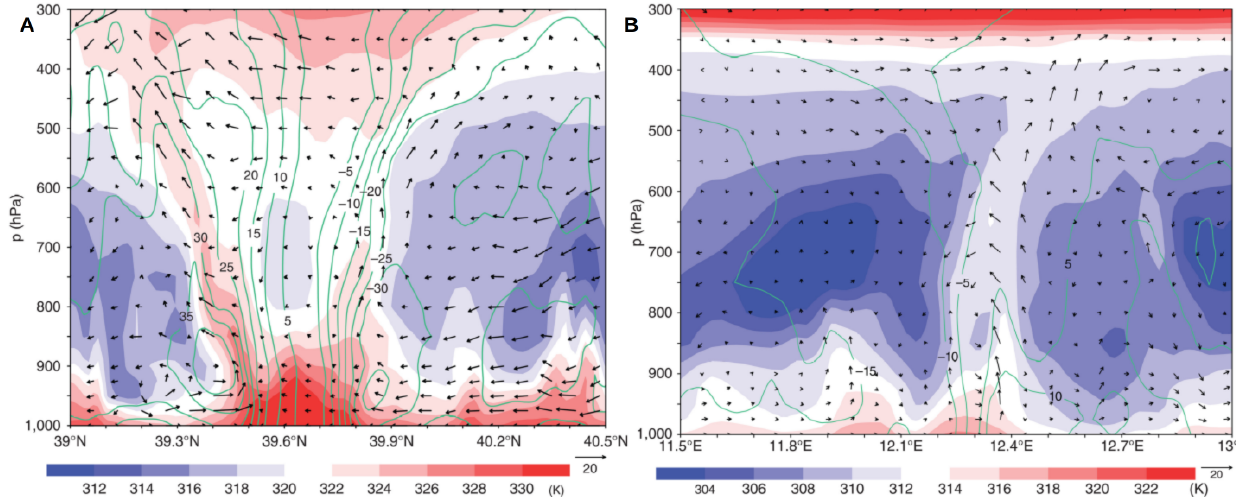
Figure 5. (a) The October 1996 case: vertical cross-section of θ e (colours), storm-relative winds (vectors) and absolute momentum (lines, contour interval = 5ms − 1 ; zero not shown) near the cyclone centre (longitude = 12.45 ◦ E) (WRF model run, 3km grid spacing) at 10:00UTC on 9 October 1996; (b) like in (a) but for the December 2005 case (latitude = 34.1 ◦ N; 06:00UTC on 15 December 2005). The wind vectors are drawn every five grid points in the horizontal. Typical tropical cyclone features can be identified, such as upward motion along isosurfaces of absolute momentum, large-scale moisture convergence in low levels and near-moist-neutrality for ascending particles. Reprinted from Miglietta and Rotunno (2019) with